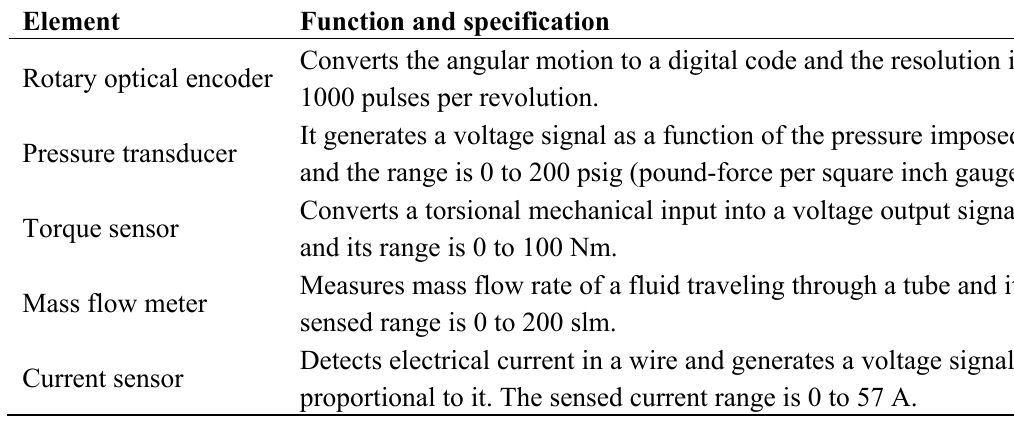
Table 1. The sensors of the hybrid power platform.